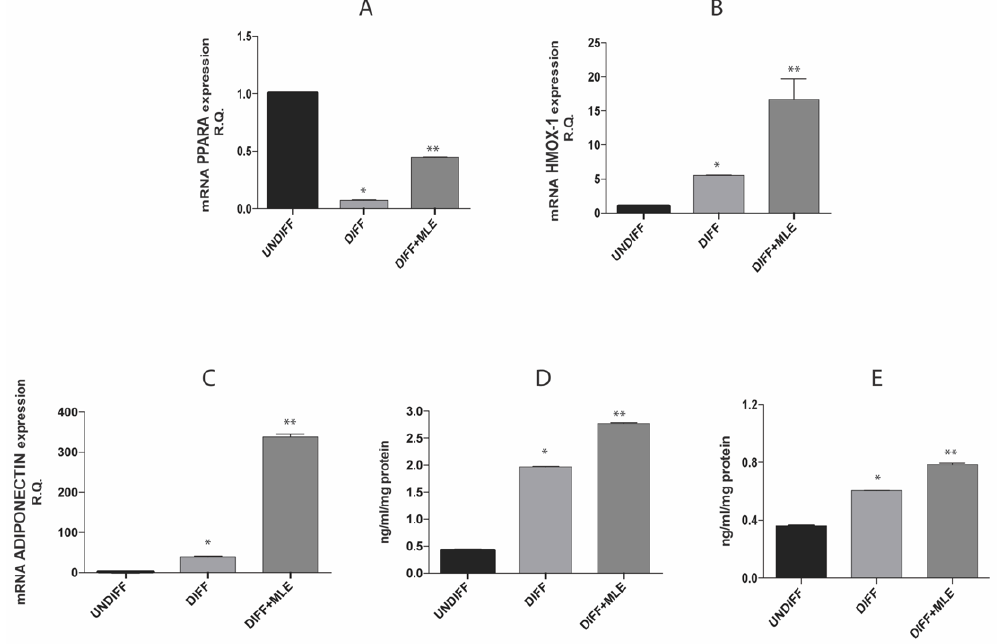
Figure 7. Gene expression of PPAR- α ( A ), HO-1 ( B ) and adiponectin ( C ) evaluated by RT-PCR. In image ( D ) protein adiponectin cellular levels and in ( E ) protein adiponectin released in cell culture supernatant tested by enzyme-linked immunosorbent assay (ELISA). Bars represent the mean ± SEM of six independent experiments. * p < 0.05 versus undifferentiated cells; ** p < 0.05 versus differentiated cells.